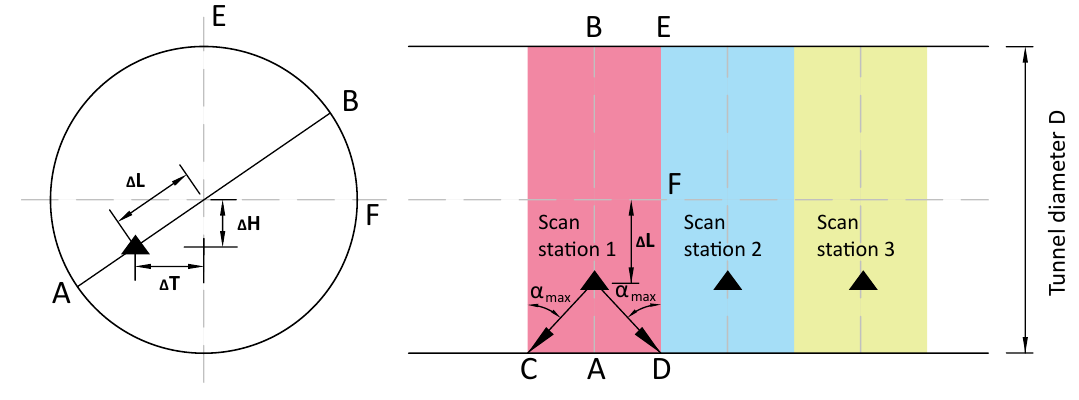
Figure 7. The geometric arrangement of the scan station of terrestrial laser scanning (TLS) in circular tunnels: the left picture illustrates the cross section which contains points A and B in the right picture; the right picture is the longitudinal section of tunnel and contains points A and B in the left